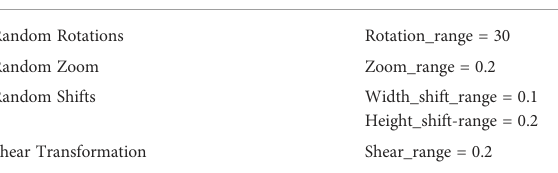
TABLE 3 Parameters of the augmentation techniques applied in the current study.